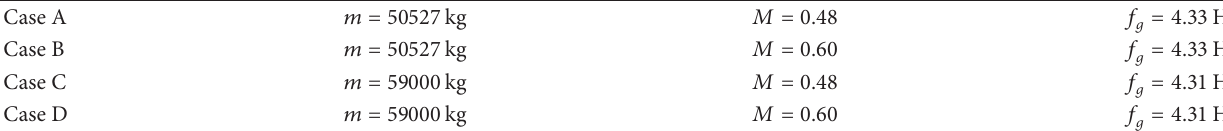
Table 3: Analyzed cases: different mass and flight conditions.